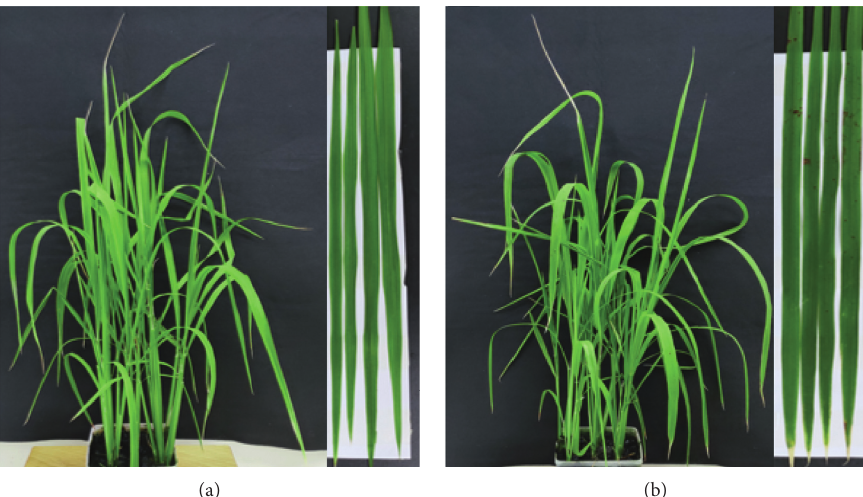
Figure 3: Phytotoxicity studies and images after incubation with different concentrations of compound 3l (treatment for 7 days): (a) 0 μ g/ mL and (b) 200 μ g/mL.